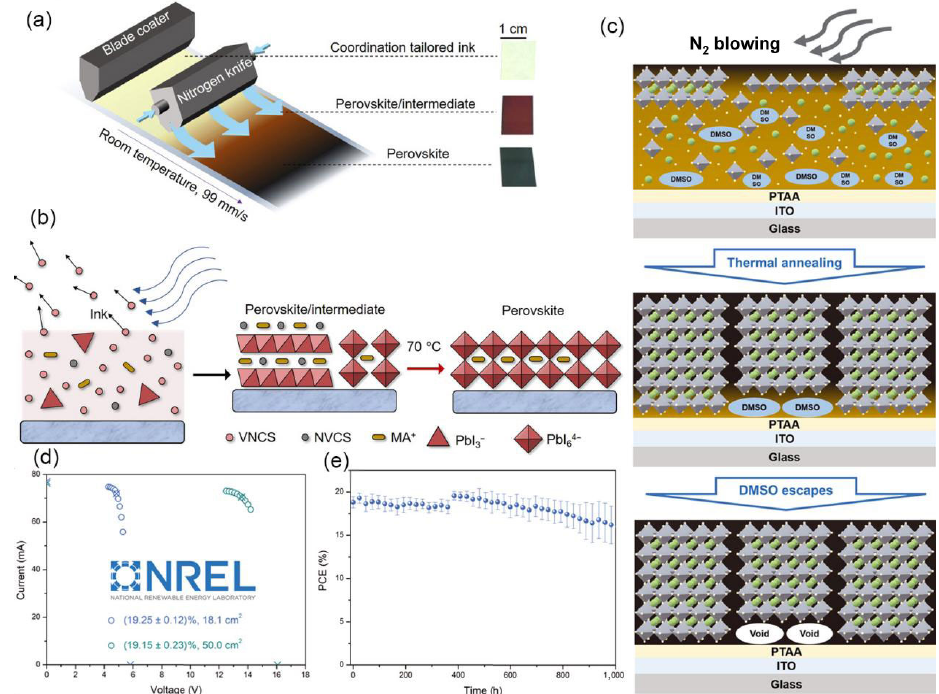
Figure 3 (a) Schematic illustration for N 2 -knife-assisted blade coating of perovskite films at 99 mm/s at room temperature using coordination tailored ink. Insets: photograph images of wet, perovskite/intermediate and perovskite films. (b) Schematic illustration of the wet film drying into perovskite/ intermediate film and perovskite film with full crystallization. Reproduced with permission from Ref. [36], © Deng, Y. H. et al. 2019. (c) Schematic illustration for the void formation at the buried interfaces, (d) NREL certified performance of PPMs with aperture areas of 18.1 and 50.0 cm 2 . (e) Long-term operational stability of five PPMs under simulated 1-sun illumination at 50 °C. Reproduced with permission from Ref. [39], © Chen, S. S. et al.